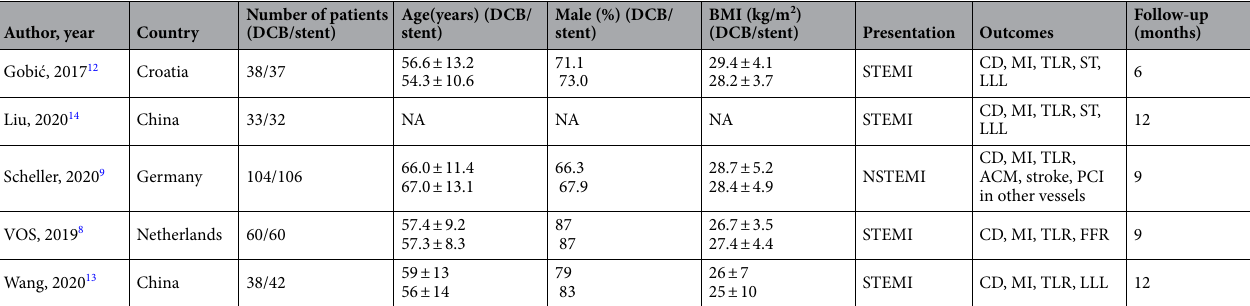
Table 1. Characteristics of the included studies. DCB drug-coated balloon, BMI body mass index, STEMI ST-segment elevation myocardial infarction, NSTEMI non-ST-segment elevation myocardial infarction, CD cardiac death, MI myocardial infarction, TLR target lesion revascularization, ST stent thrombosis, LLL late lumen loss, ACM all-cause mortality, PCI percutaneous coronary intervention, FFR fractional flow